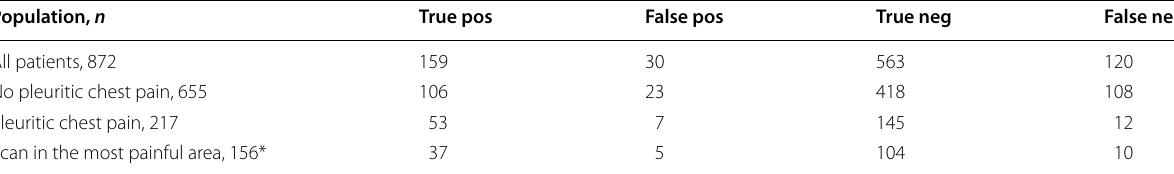
Table 3 Lung ultrasound in the diagnosis of pulmonary embolism Population, n